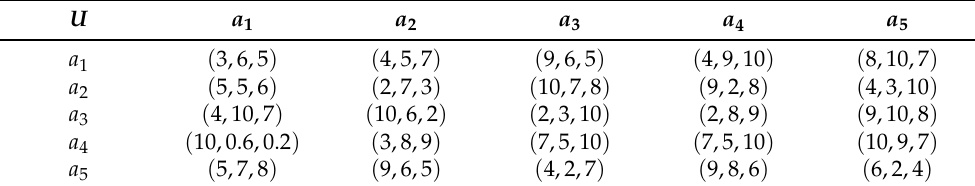
Table 2. The tabular representation of a three-way fuzzy relation R